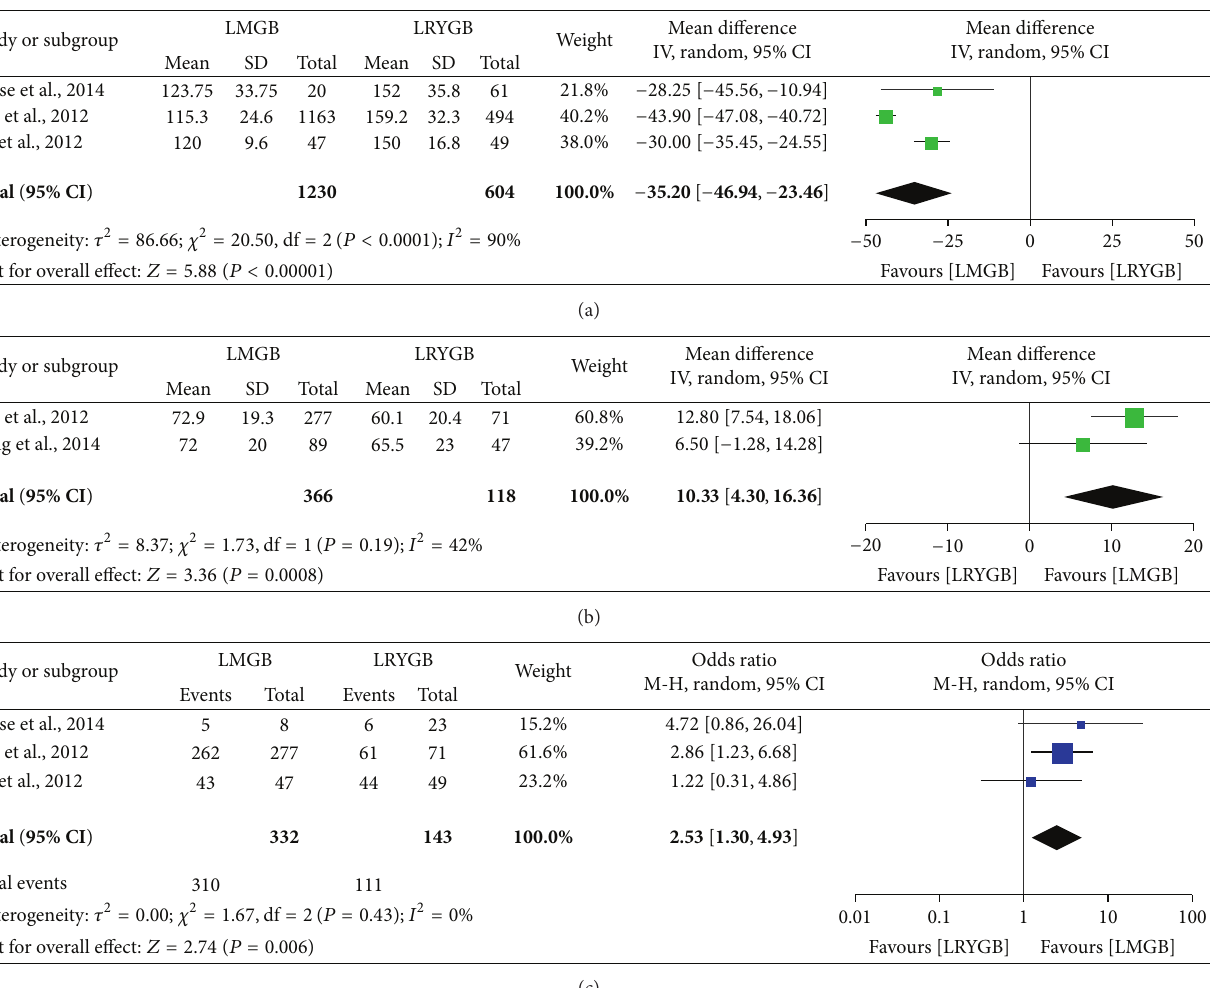
Figure 4: Meta-analysis comparing LMGB with LRYGB. (a) Operation time. (b) 1-year postoperative %EWL. (c) Overall remission rate of